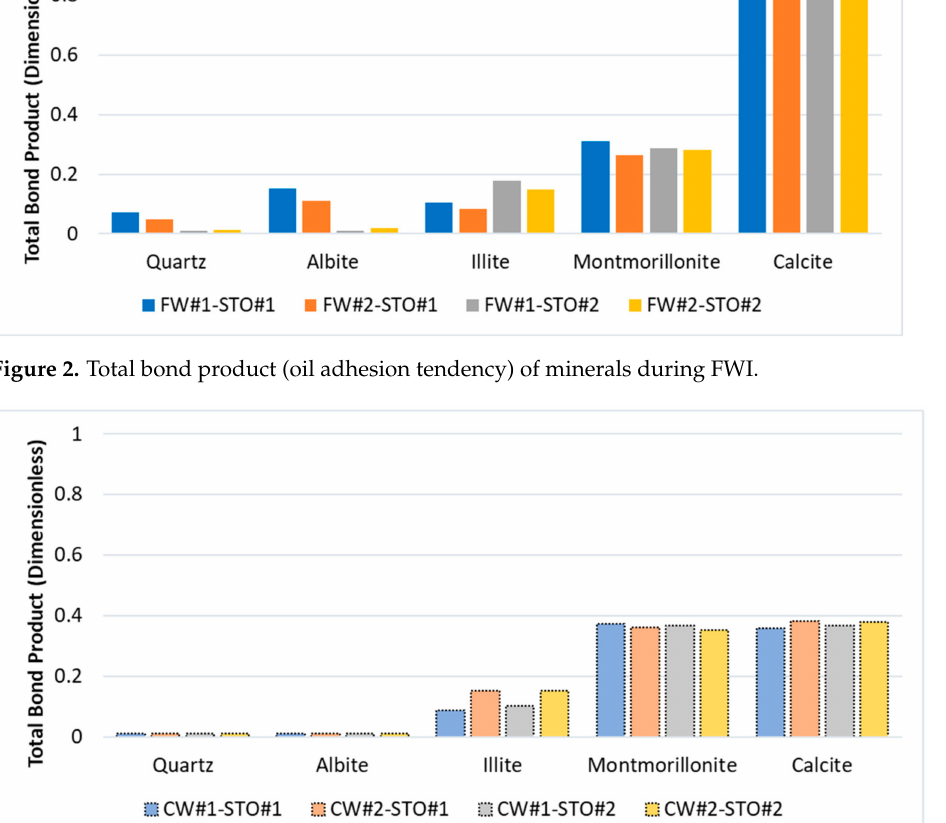
Table 4. SCM input parameters.